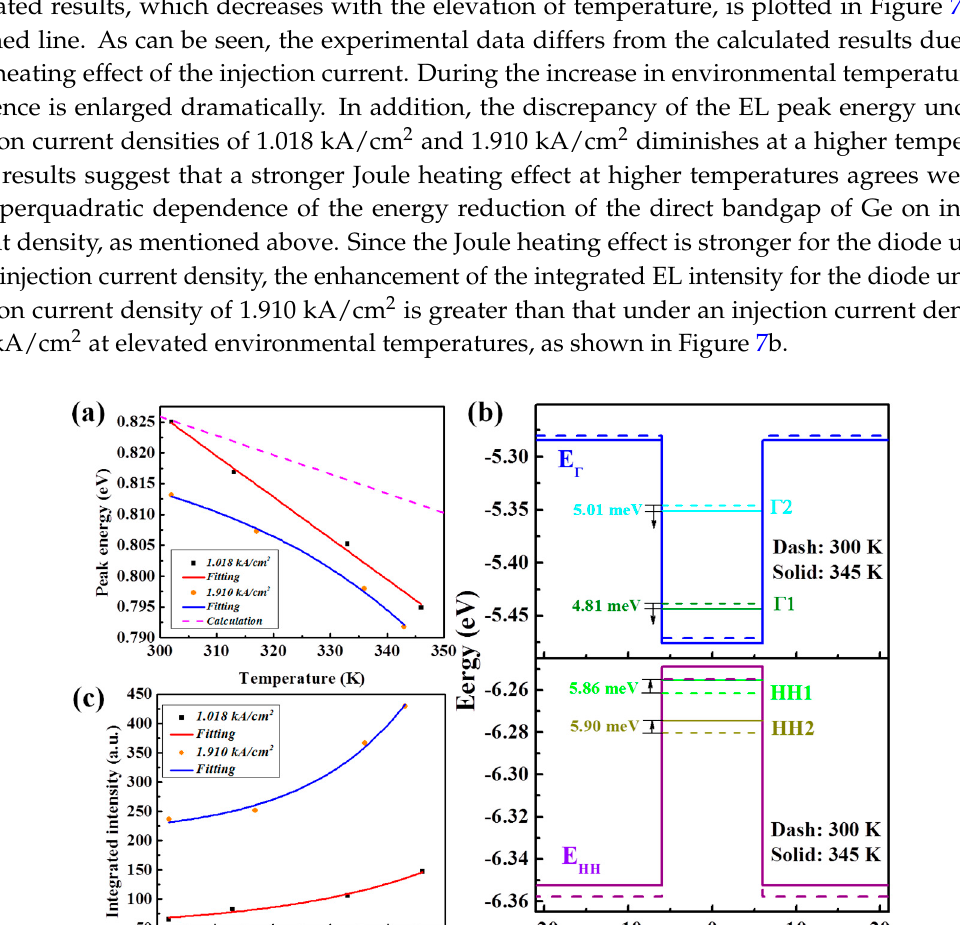
Figure 8. The relationship between the integrated intensity ( L ) from diode and injection current density ( J ) characterized empirically by L ~ J m .